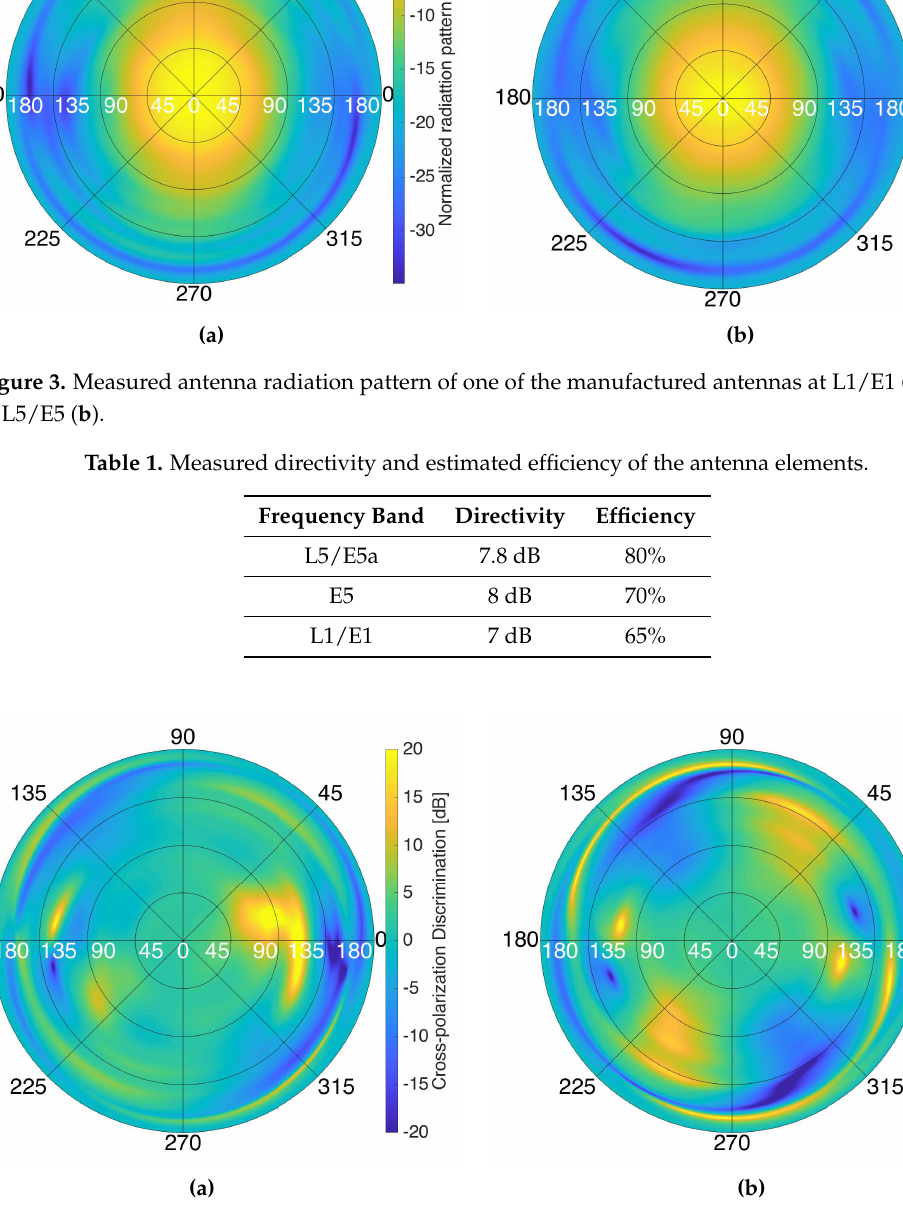
Figure 4. Measured cross-polarization discrimination patterns at L1/E1 ( a ), and L5/E5a ( b ) frequency bands. The colorscale was limited to ± 20 dB to ease the